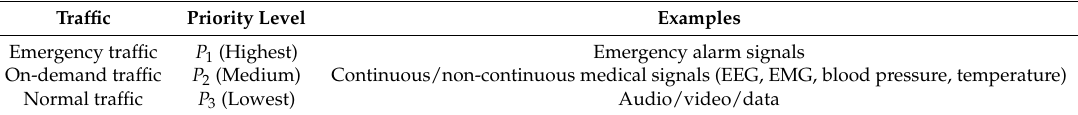
Table 1. TAP-MAC traffic priority levels. EMG: electromyogram; EEG:electroencephalogram